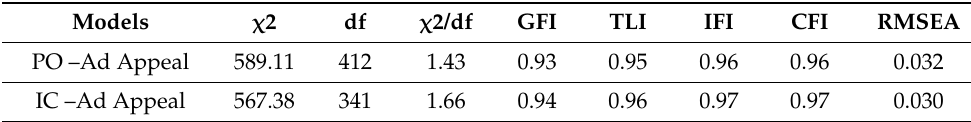
Table 3. Confirmatory factor